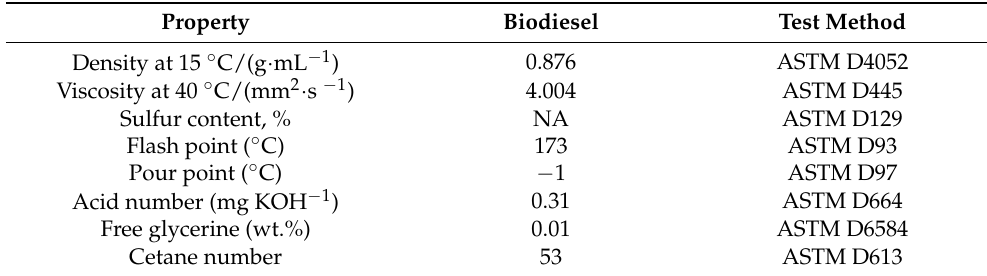
Table 2. Basic Characterization of